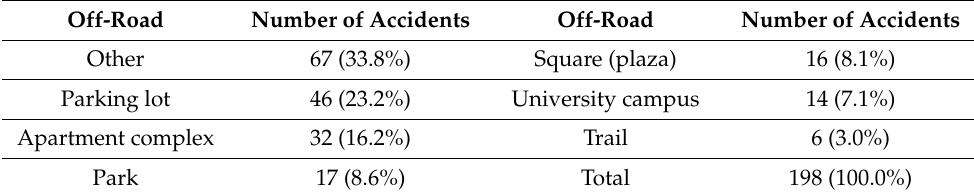
Table 8. Location of off-road